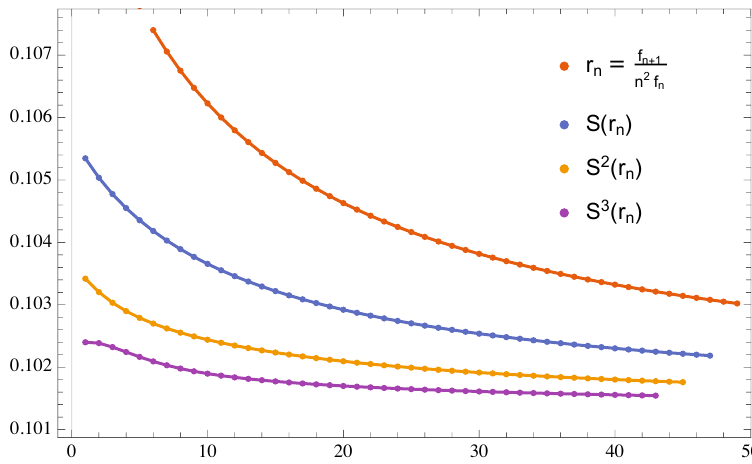
Figure 1 . Ratio r n = n − 2 f n +1 /f n for the coefficients in the expansion of the free energy, together with the first three Shank transforms [34] as function of n . The convergence at large n to a constant value of O (1) indicates a double-factorial leading behavior f of the non-perturbative